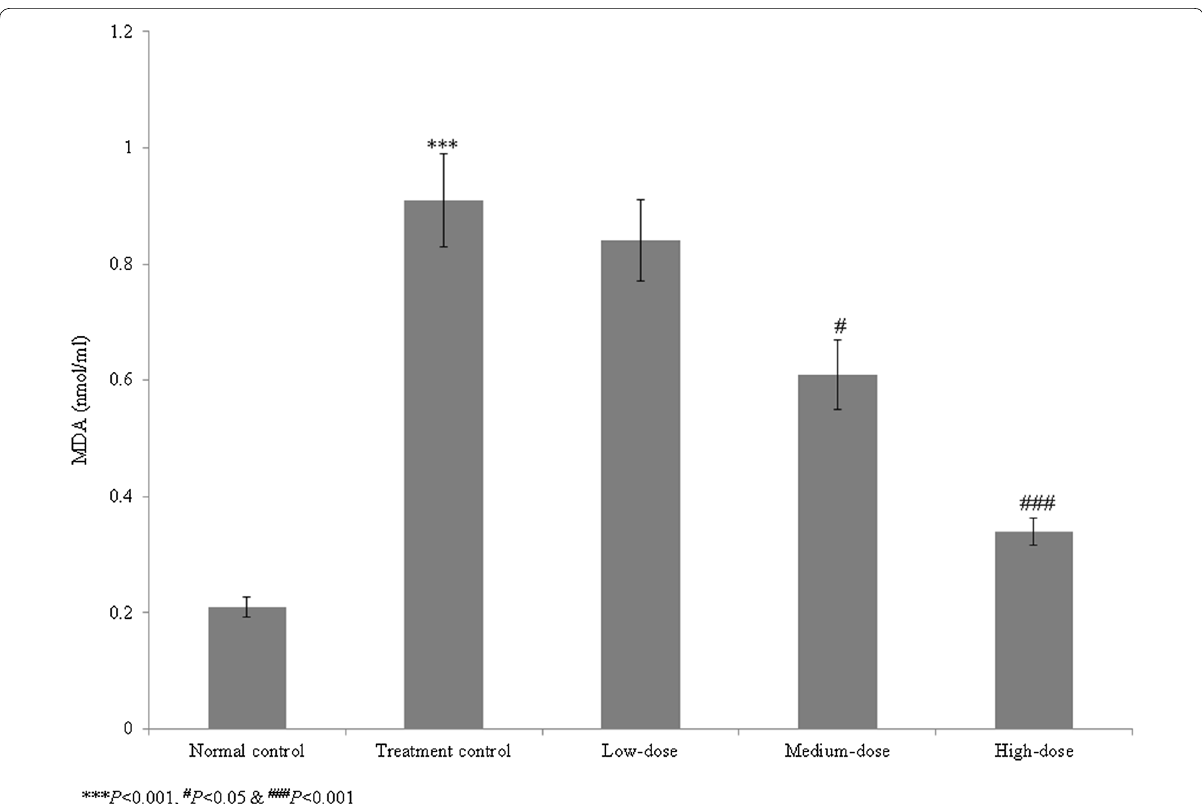
Fig. 3 Effect of catalpol on lipid peroxidation in human induced pluripotent stem cells with aconitine-induced cardiac arrhythmia. Catalpol supplementation decreased lipid peroxidation by 7.7, 33, and 62.6% at 1, 10, and 100 µM respectively. *** P < 0.001 vs. Group I; # P < 0.05 and ### P < 0.001 vs. Group II